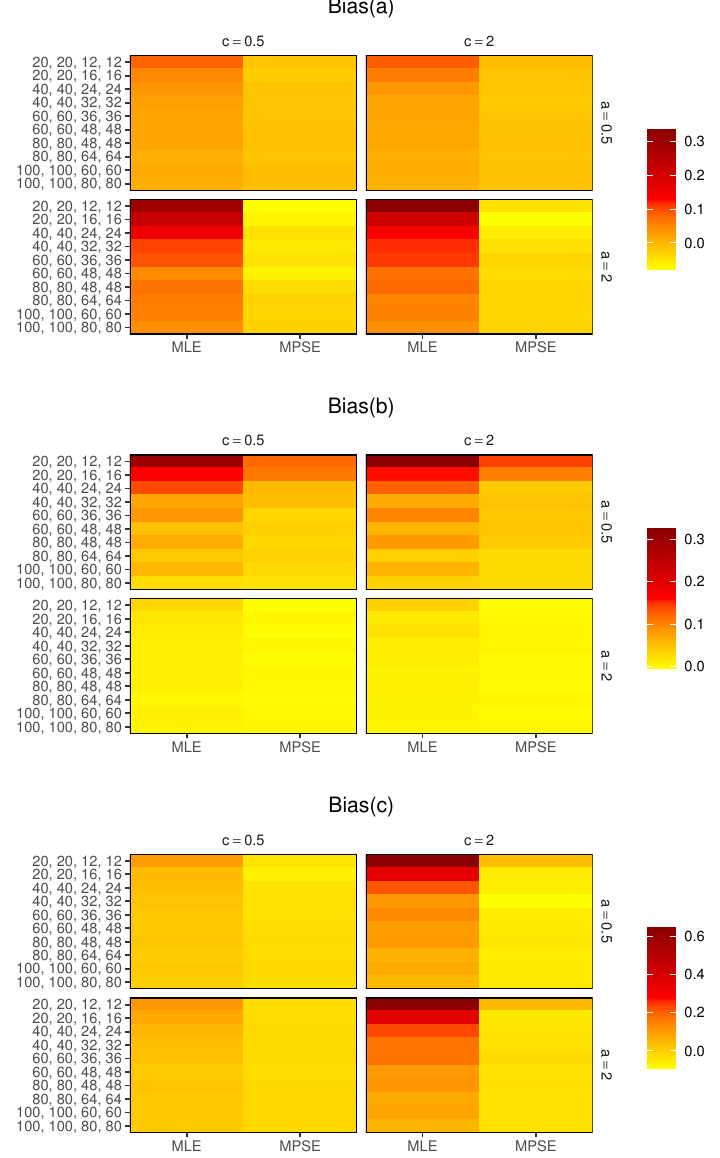
Figure 3. The heatmaps of the simulated biases of the MLEs and MPSEs of a , b and c